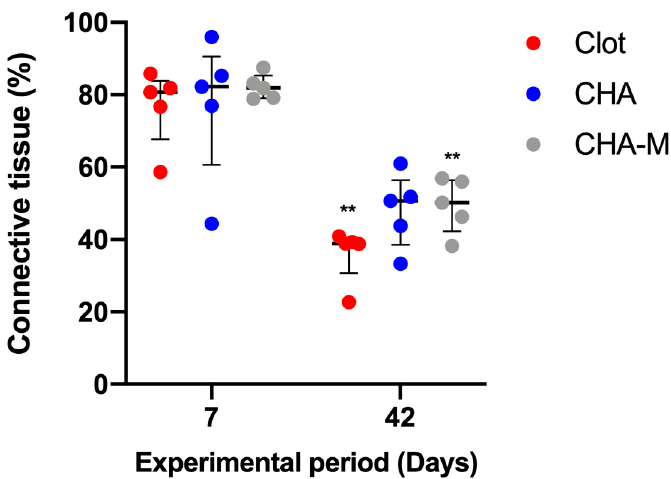
Figure 7. Percentage of connective tissue of all groups after 7 and 42 days after grafting. Results are presented as a median and IQR ( n = 5). Kruskal–Wallis and Dunn’s post-test were applied to investigate differences between the groups at the same time point. Mann–Whitney test was used to evaluate differences between the same experimental group in different time points. The **, p = 0.007 represents statistical difference between the same group in different experimental periods.